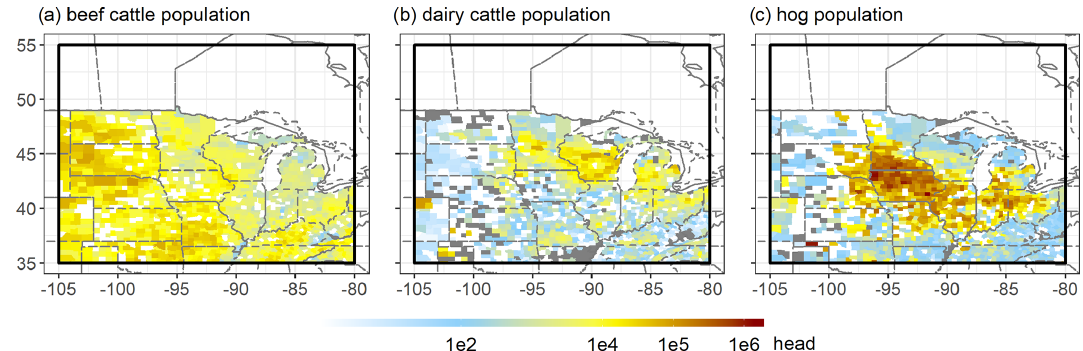
Figure 9. County-level animal populations for (a) beef cattle, (b) dairy cattle and (c) hogs, based on the 2017 US Department of Agriculture Census of Agriculture (USDA-NASS, 2018). Table 1. Derived methane emission scale factors for livestock by animal category. Animal Analysis Model grid Seasonal scale factors ∗ category counties cells Summer Winter